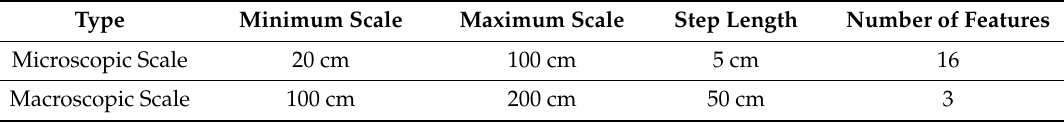
Table 2. Different measurement scales.